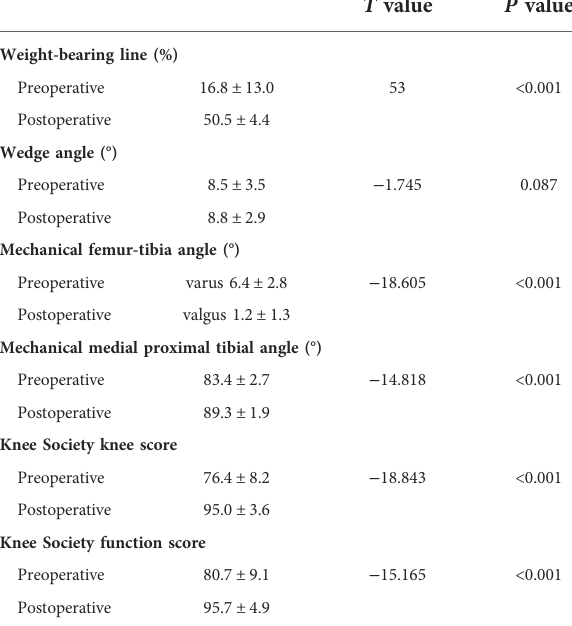
TABLE 3 Results of HTO using the SolidWorks